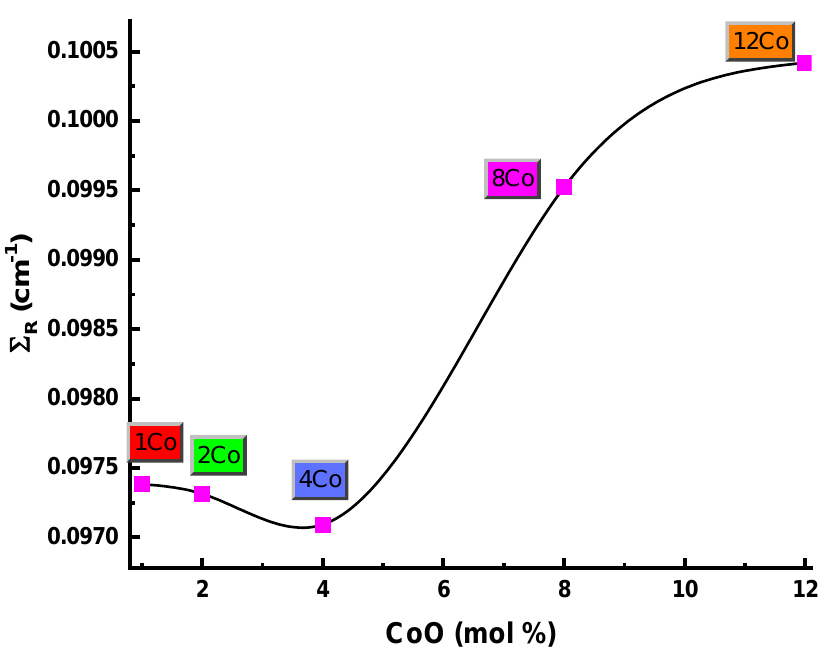
Figure 13. Removal cross sections for fast neutrons- Σ R values of samples labeled as 1Co, 2Co, 4Co, 8Co, and 12Co for glass samples.